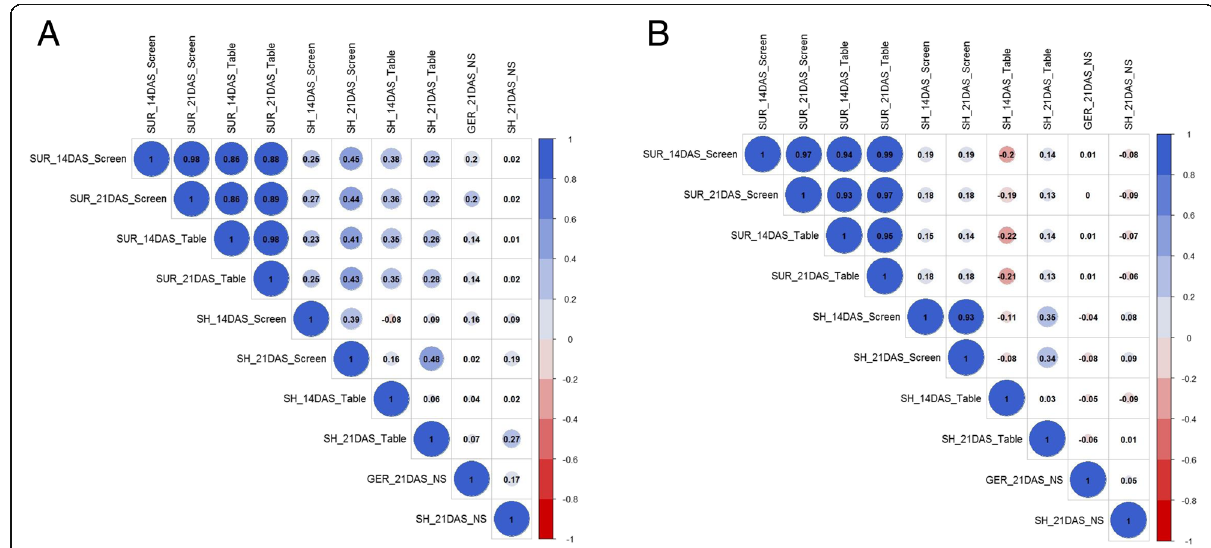
Fig. 2 Correlation among survivability, seedling height, and germination (control) under screenhouse, tray, and control conditions (NS) for a NSIC Rc238/Kalarata and b NSIC Rc222/Kalarata